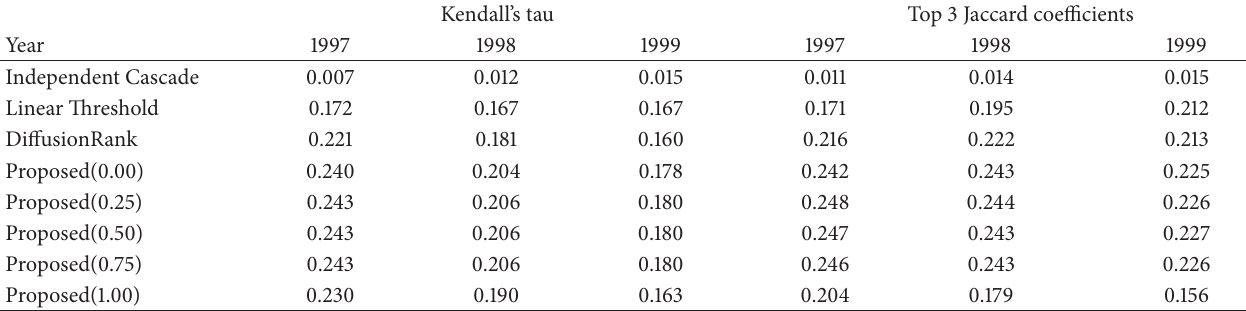
Table 2: Compare the result after one round for each model with the ground truth of years 1997, 1998, and 1999.